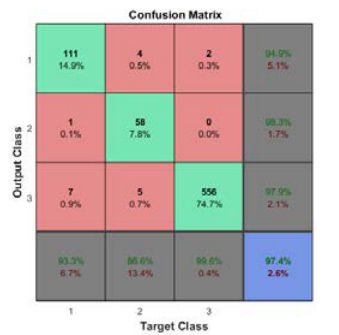
Figure 7. Confusion matrix of the deep network